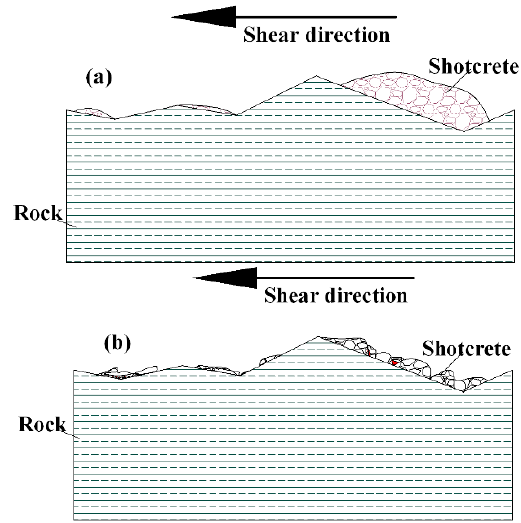
Figure 14. Shear failure model: ( a ) standard environment and ( b ) high temperature environment.